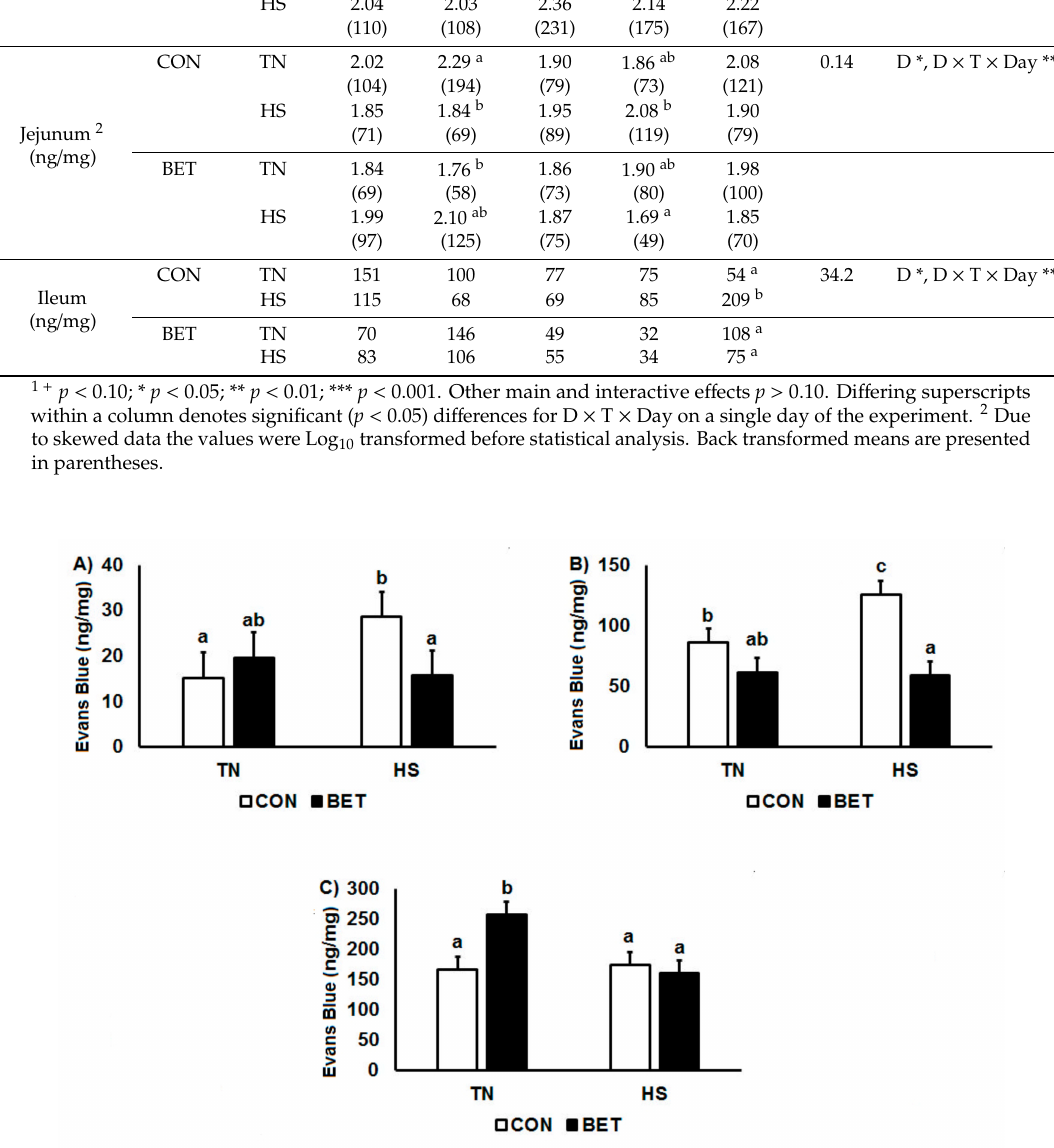
Figure 2. Changes in the distribution of Evans Blue Dye in ( A ) psoas major, ( B ) kidney, and ( C ) spleen in broilers during a thermoneutral (TN) vs. heat stress (HS) environmental challenge. Broilers were fed either a control diet (CON) or betaine diet (BET), and the mean represents the main e ff ect of 5 time points (1, 2, 3, 7 and 10 day challenge). Means with di ff ering superscripts denote p < 0.05. Refer